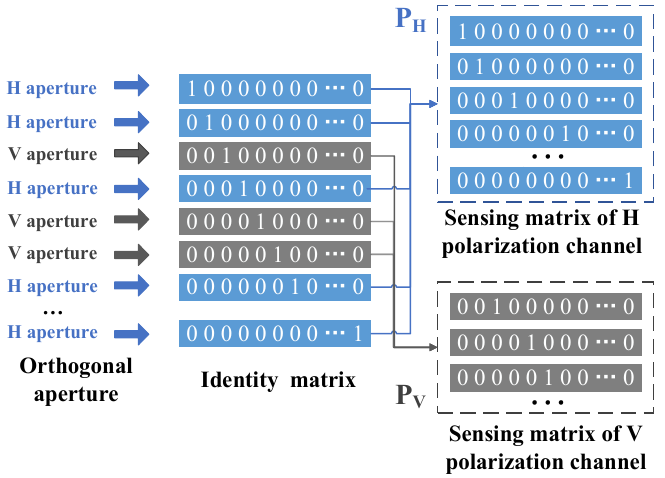
Figure 4. Orthogonal coding aperture model.